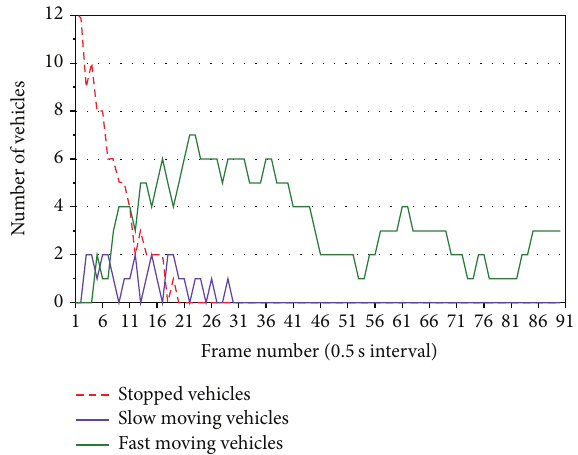
Figure 17: Fluctuations of the number of vehicles in lane 2.